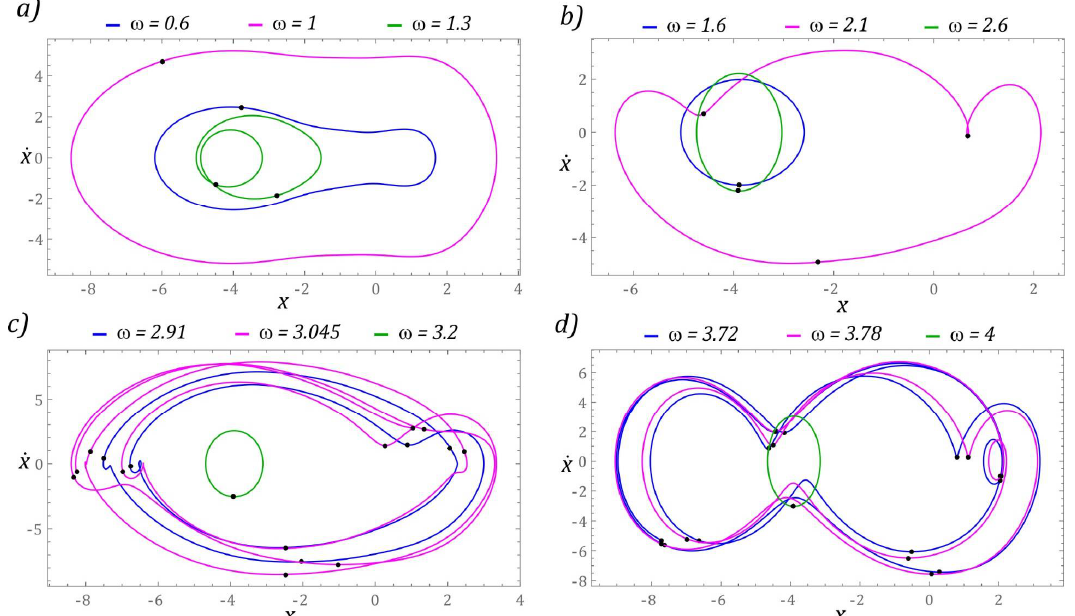
Figure 10. Sample graphic images of periodic solutions. The cases ( a – d ) show the selected solutions for increasing ω . The corresponding Poincaré maps with multiple black points indicate higher period solutions.